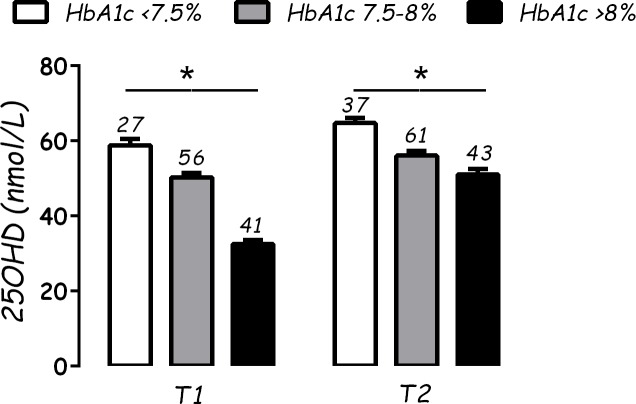
Vitamin D (25OHD) levels (nmol/L) according to glycated hemoglobin (HbA1c) levels (%).On each bar graph are reported the number of subjects (n); * = p<0.01.